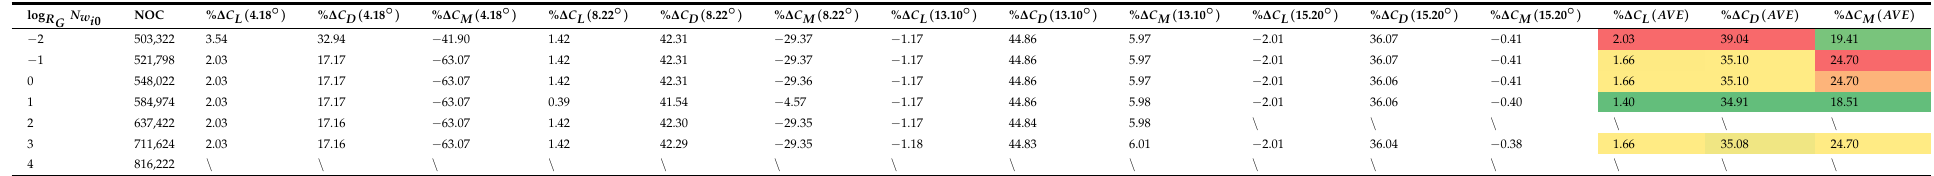
Table 19. Comparison of results of C-mesh based on various wake nodes with that of experimental benchmark data adopted from [25] in relative differences with 300 nodes in wake directions for reference